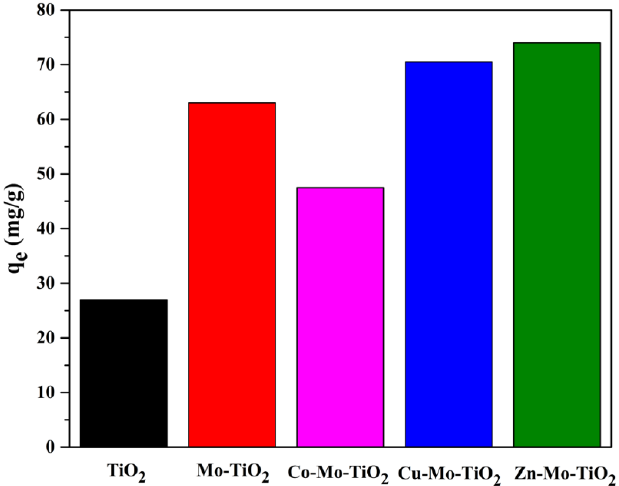
Figure 18. The adsorption capacities of Mo ‐ TiO 2 , Co ‐ Mo ‐ TiO 2 , Cu ‐ Mo ‐ TiO 2 , and Zn ‐ Mo ‐ TiO 2 .